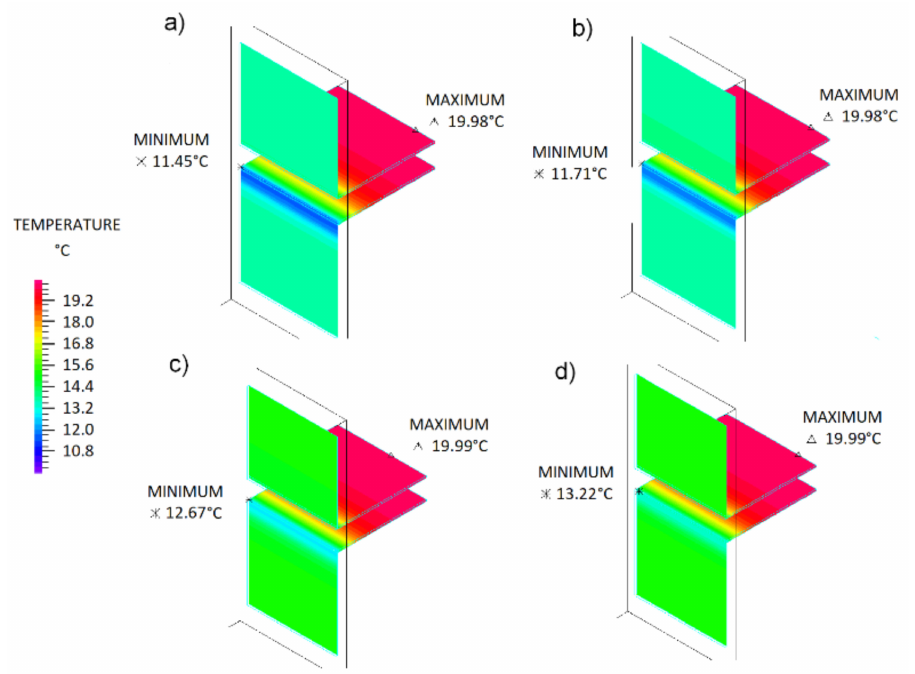
Figure 10. Temperature distribution in the model on the internal surfaces of the partitions at the time of the lowest temperature on the inner wall surface; ( a ) variant 1, ( b ) variant 2, ( c ) variant 3, ( d ) variant